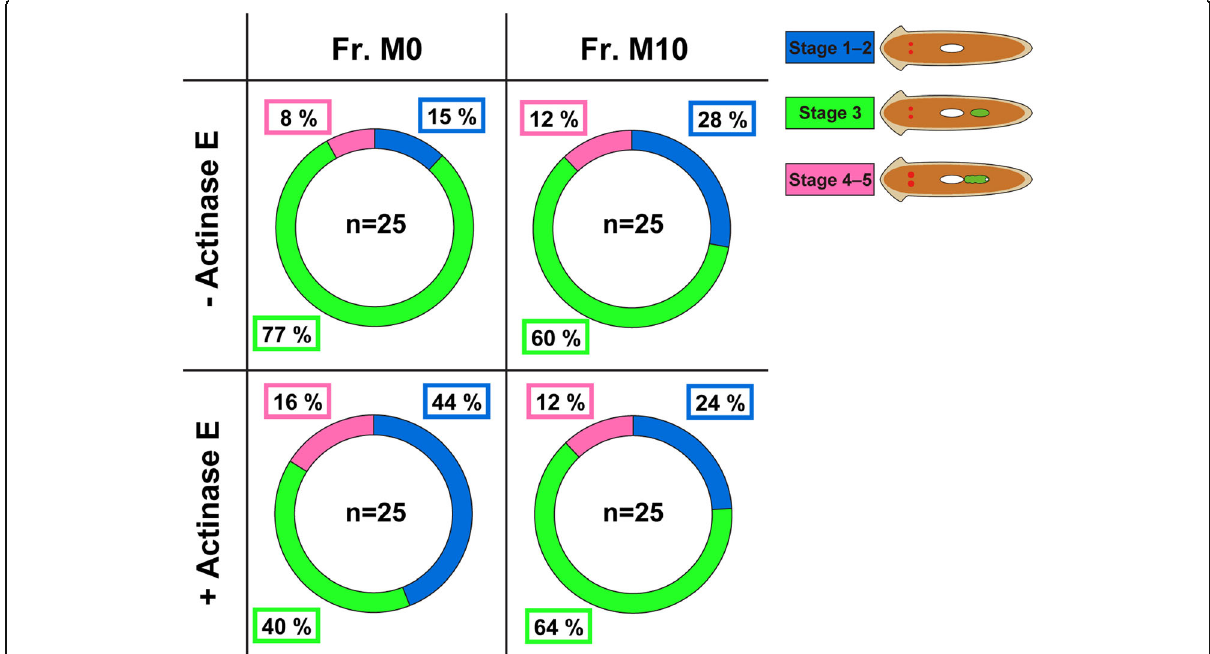
Fig. 7 Comparison of sex-inducing activity between + and – Actinase E samples. Test worms at the three stages of sexual induction identified by external observation were expressed as a doughnut chart. The illustrations of worms in the figure correspond to those in Fig. 3b. The number of test worms after the bioassay is shown in the center of a doughnut chart. The percentage of worms at each of the three stages of sexual induction is shown in the box drawn by colored line. There was no significant difference between Fr. M0+Actinase E and Fr. M0 – Actinase E, and Fr. M10+ Actinase E and Fr. M10 – Actinase E (a chi-square